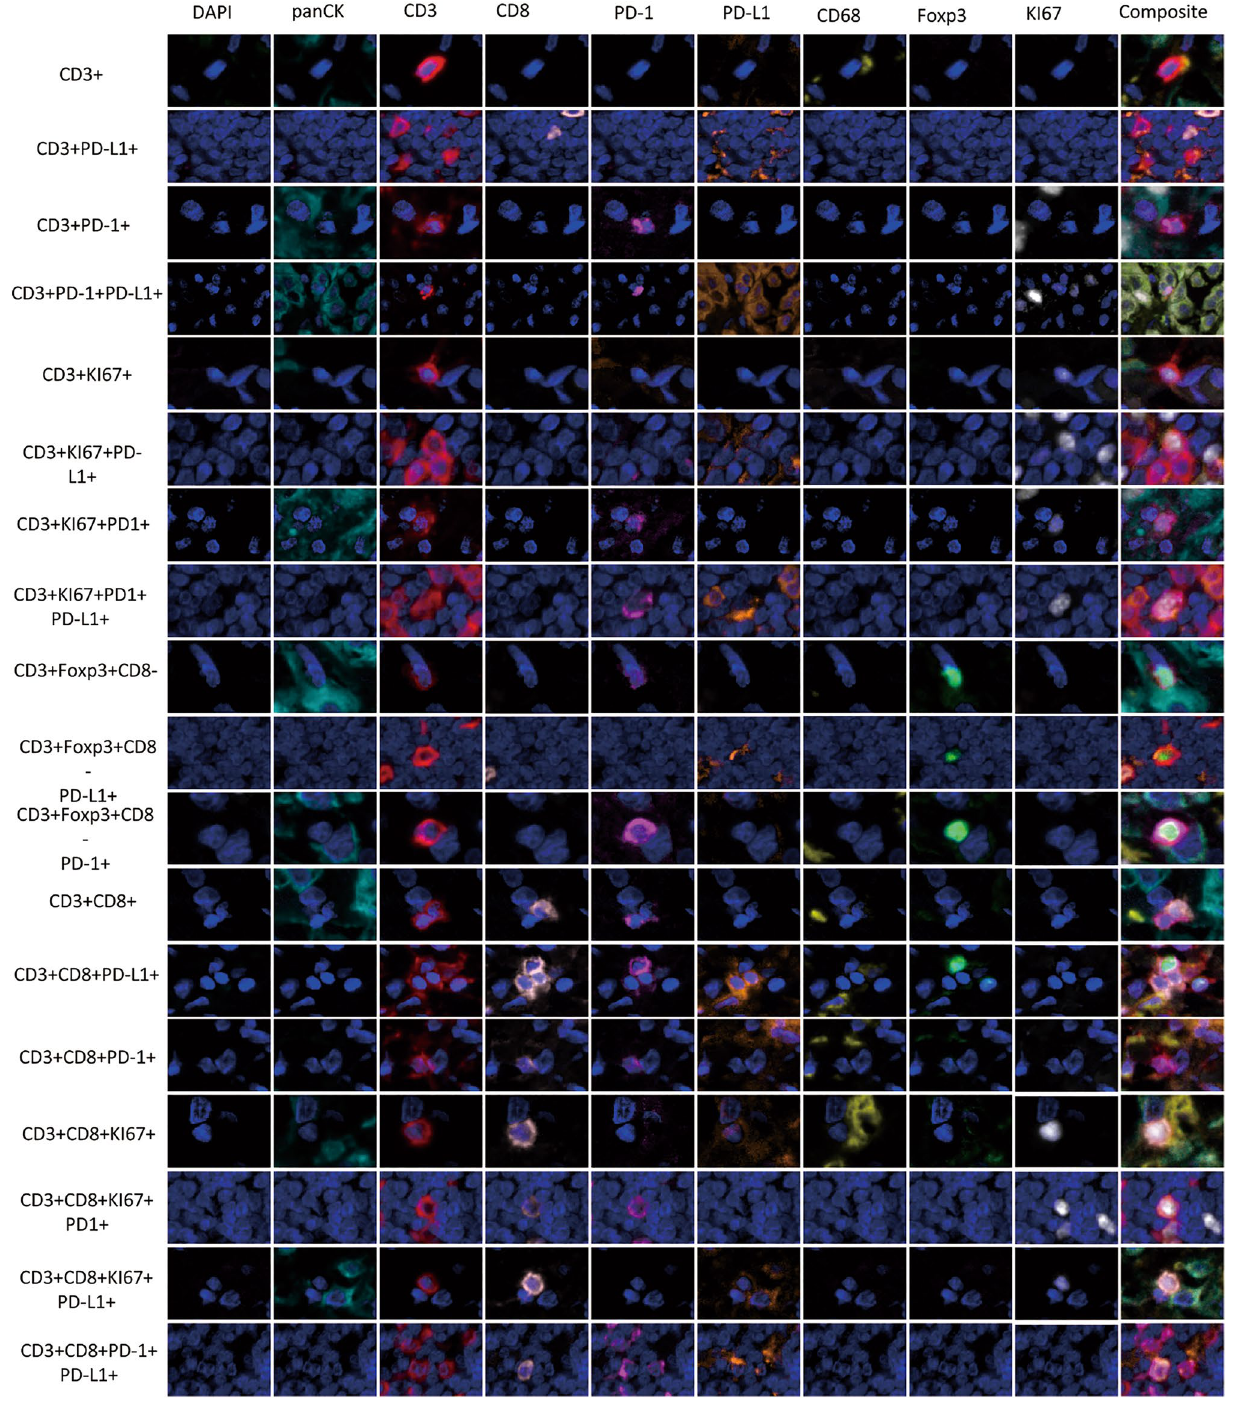
Figure 3. Microphotographs of representative examples of co-localization. Different CD3 + T-cell subpopulations observed with the multiplex immunofluorescence panel in the malignant pleural mesothelioma cohort. The images were generated using Vectra/Polaris 3.0.3 scanner system and InForm 2.4.8 image analysis software (Akoya